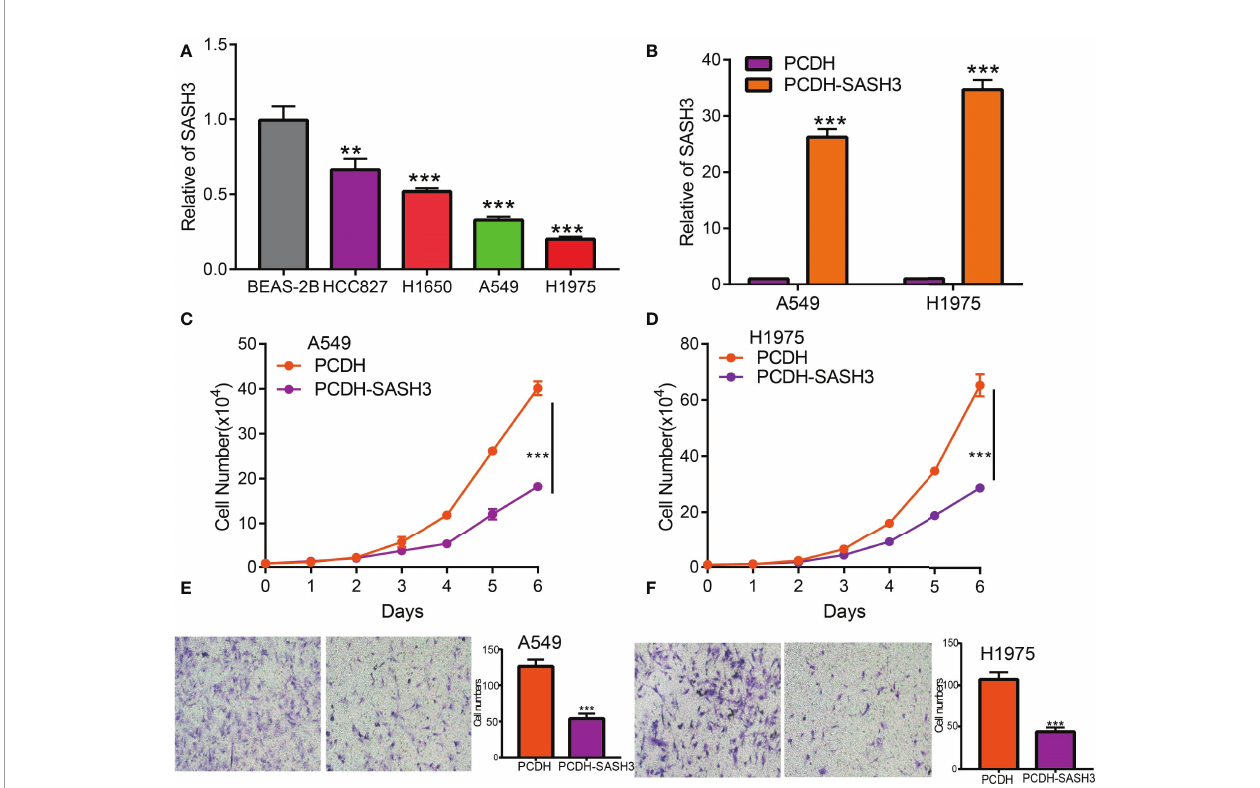
FIGURE 13 | SASH3 inhibits cancer cell growth, cell migration, and induced cell cycle arrest. (A) The relative expression of SASH3 in LUAD cell lines including A549, HCC827, H1650, and H1975 examined by real-time RT-PCR; human bronchial epithelial (BEAS2B) cell line was used as control. b -actin was used as a housekeeping gene. (B) Establishment of SASH3 overexpression in A549 and H1975 cells, veri fi ed by real-time RT-PCR. (C, D) Indicated cell growth was examined by daily counting. (E, F) SASH3 overexpression inhibited A549 and H1975 cell migration by transwell assays. Quanti fi cation data were also indicated for each assay. ** p <0.01, *** p